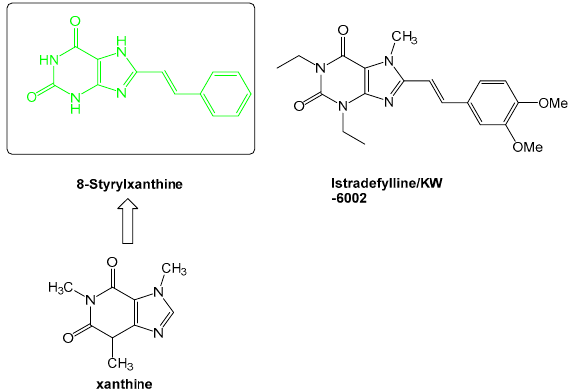
Figure 5. The progression from xanthines, such as caffeine, to the novel compound istradefylline, which was recently approved for the use in Parkinson’s diseases.